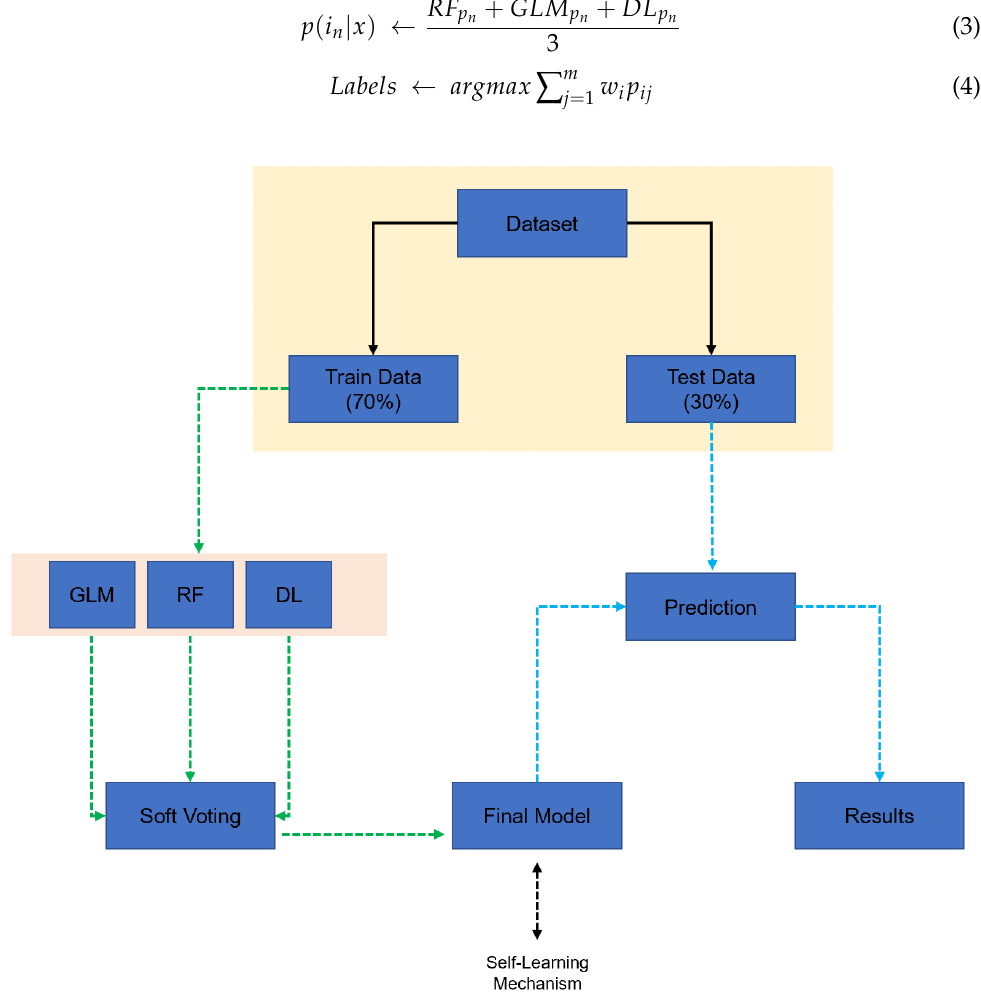
Figure 1. Workflow of the SVSL method.